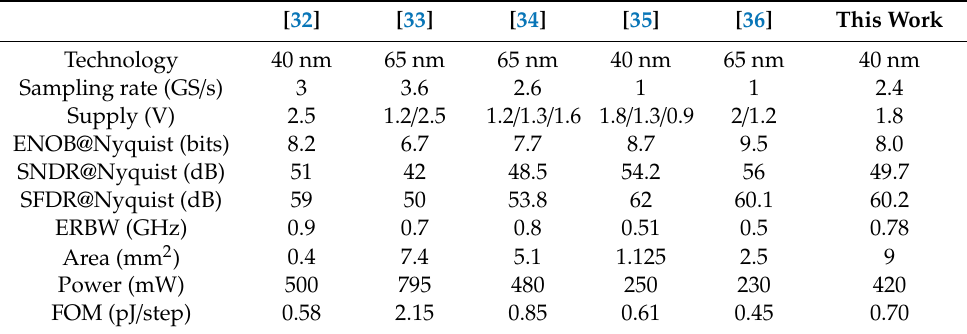
Table 2. Performance comparison with state-of-art